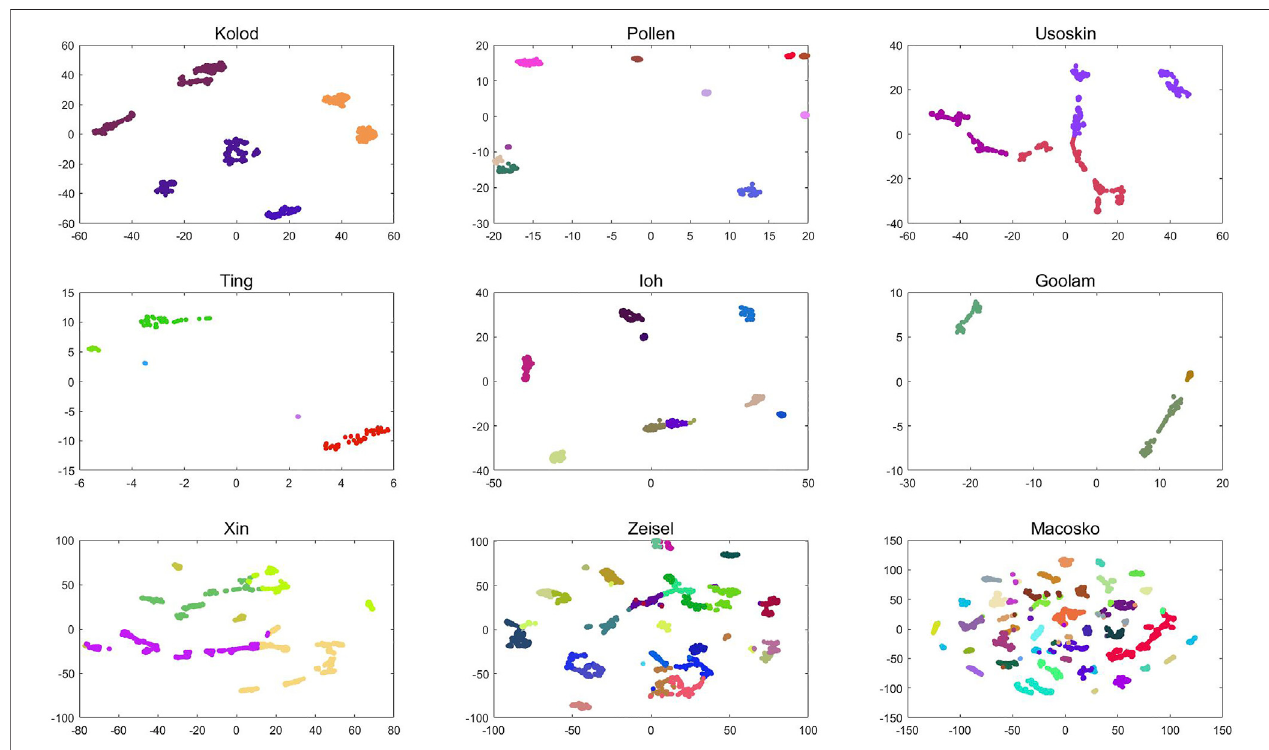
FIGURE 7 | D3K algorithm visualization